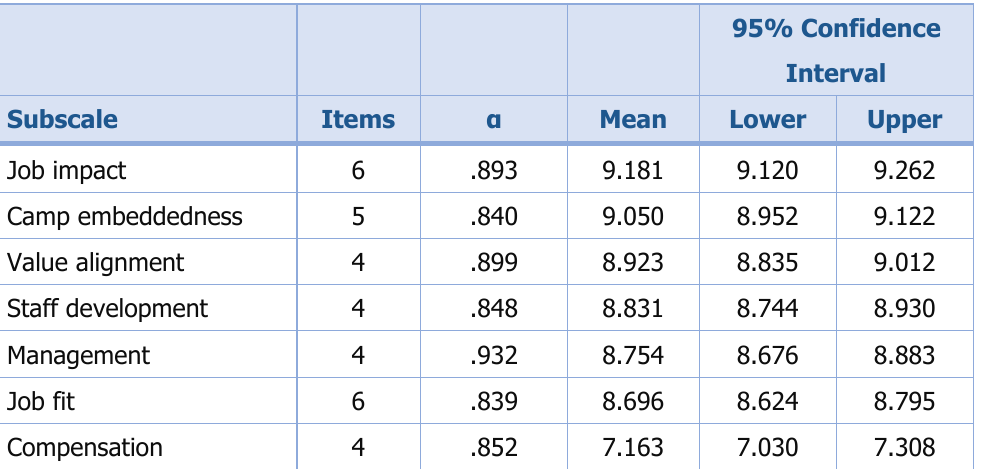
Table 3. Motivation Subscale Reliabilities and